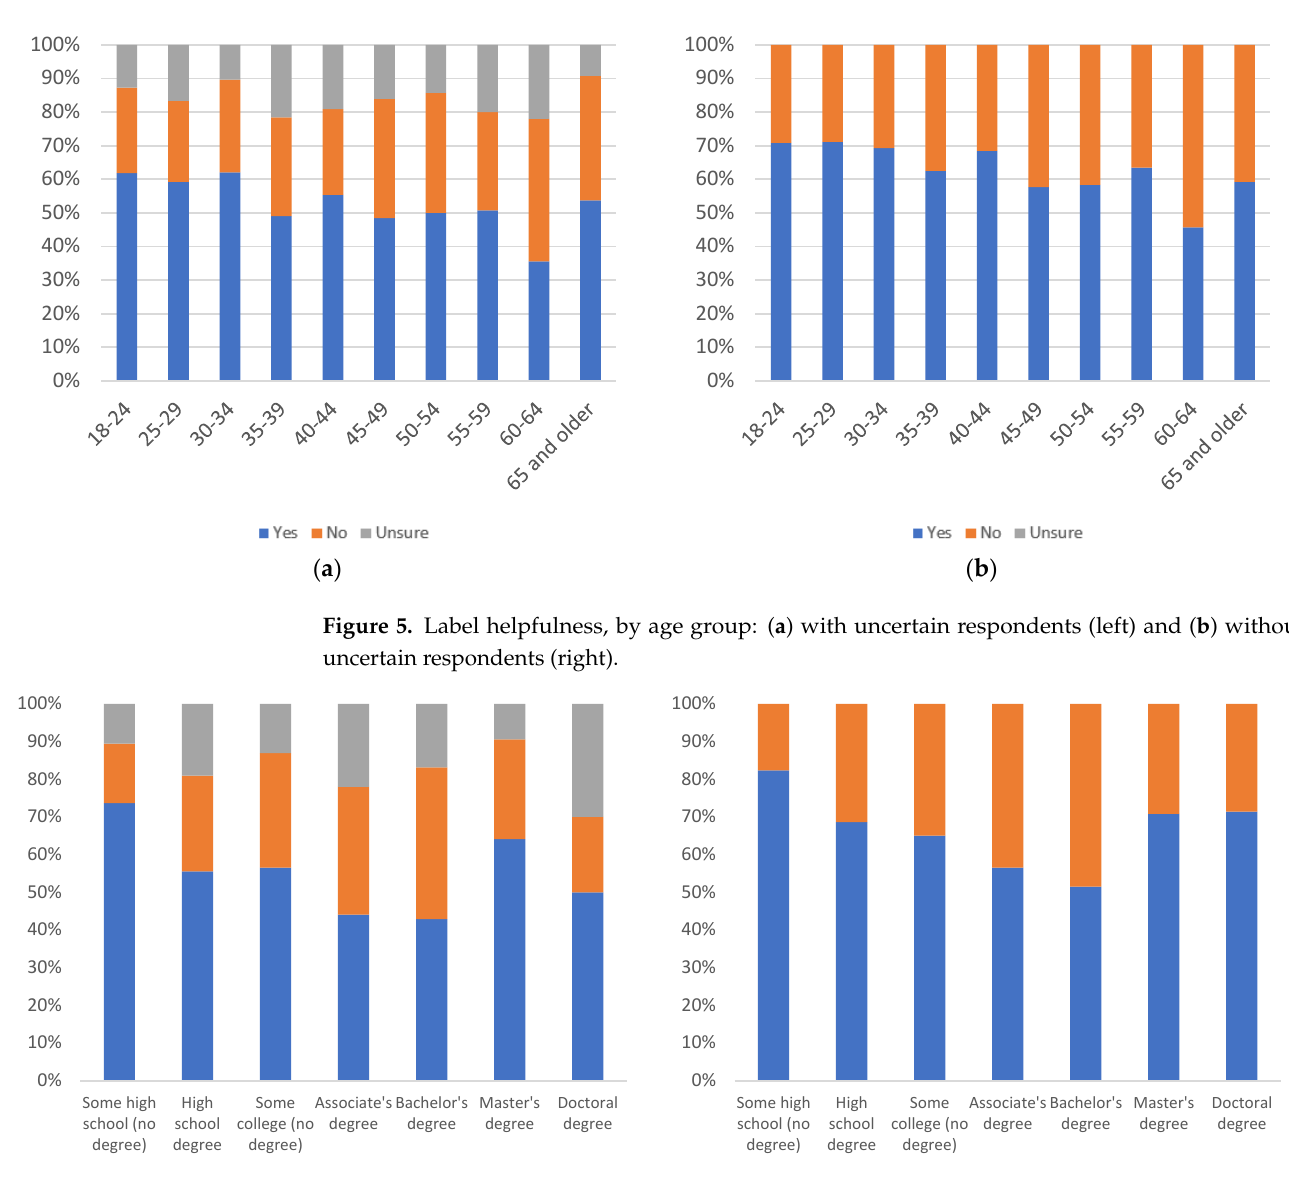
( b ) Figure 7. Label helpfulness, by gender: ( a ) with uncertain respondents (left) and ( b ) without uncer- tain respondents (right). Figures 8 – 10 consider annoyingness of informational label 1, with respondents an- swering the question “would you find this label annoying?”. In terms of age, there is no clear pattern of decline or increase in perceived annoying- ness as age increases. There are drops in yes responses at the 25 – 29, 50 – 54, and 55 – 59 age groups and an increase at the 60 – 64 age group. The number of uncertain responses also shows no discernable pattern. All age groups have less than 50% answering yes, when uncertainty is factored in. Only the 60 – 64 age group has greater than 50% yes responses, when uncertainty is not considered. This indicates a low level of annoyingness overall, amongst most age groups. By education level, there is an increase in perceived annoyingness up to the associ- ate’s degree level, then a decline up to the master’s degree level. Final ly, there is a spike at the doctoral degree level. The spike at the doctoral degree level is less pronounced, once